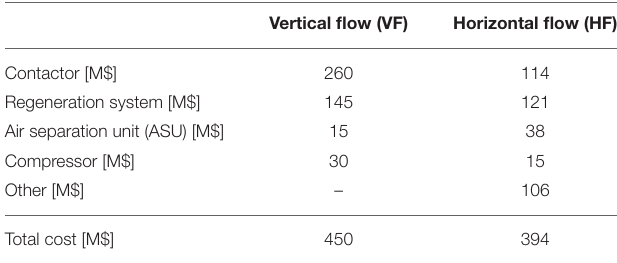
TABLE 2 | Bare module costs of major equipment in the vertical flow (VF) and horizontal flow (HF)